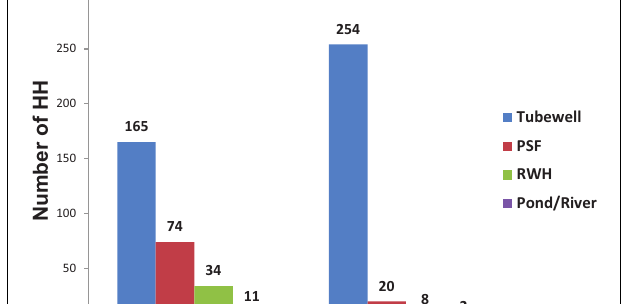
Among waters collected from 3 PSF, 2 exceeded the safe levels